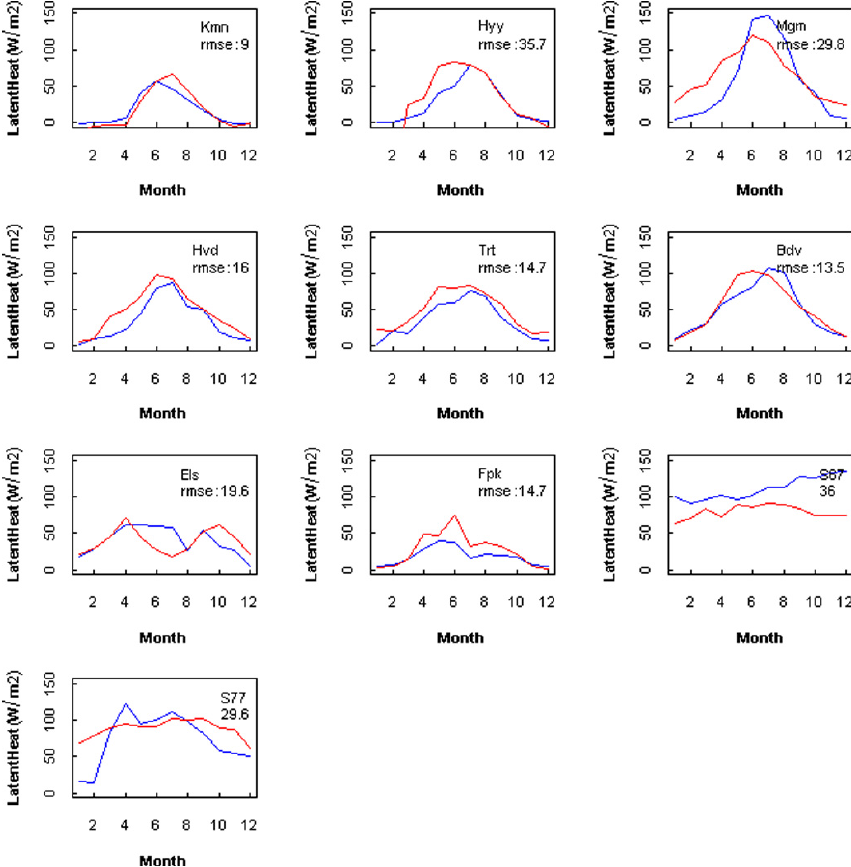
Fig. 2. Modelled (red) and observed (blue) evaporation fluxes at 10 FLUXNET sites (Kmn: Kaamanen, Hyy: Hyytiala, Mgn: Morgon Monroe, Hvd: Harvard Forest, Trt: Tharandt, Bdv: Bondville, Els: El Saler, Fpk: Fort Peck, S67: Santarem km67, S77: Santarem